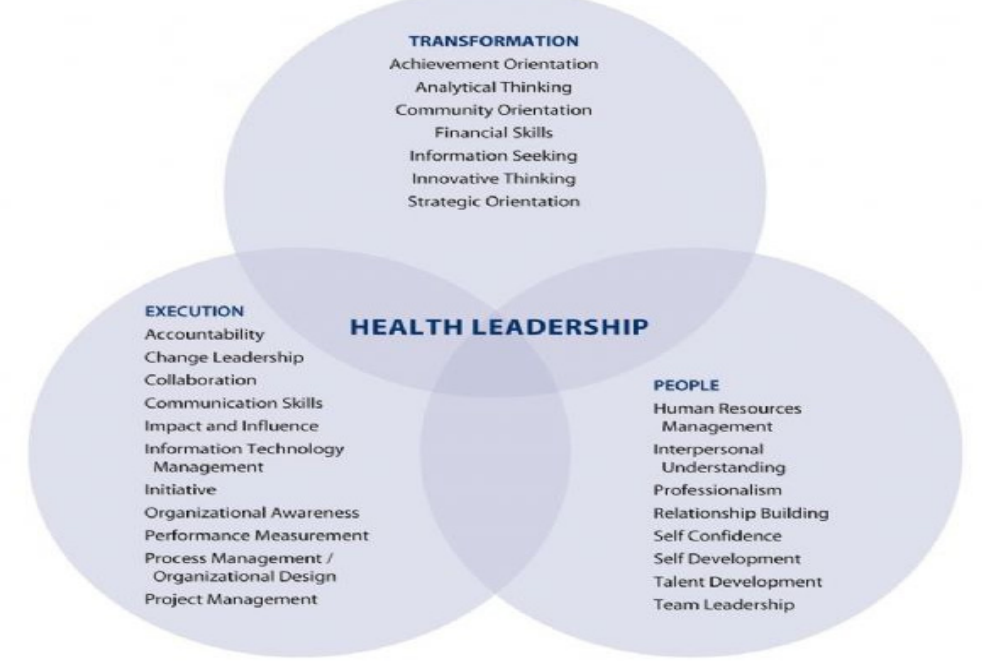
Figure 1. Domains and competencies of health